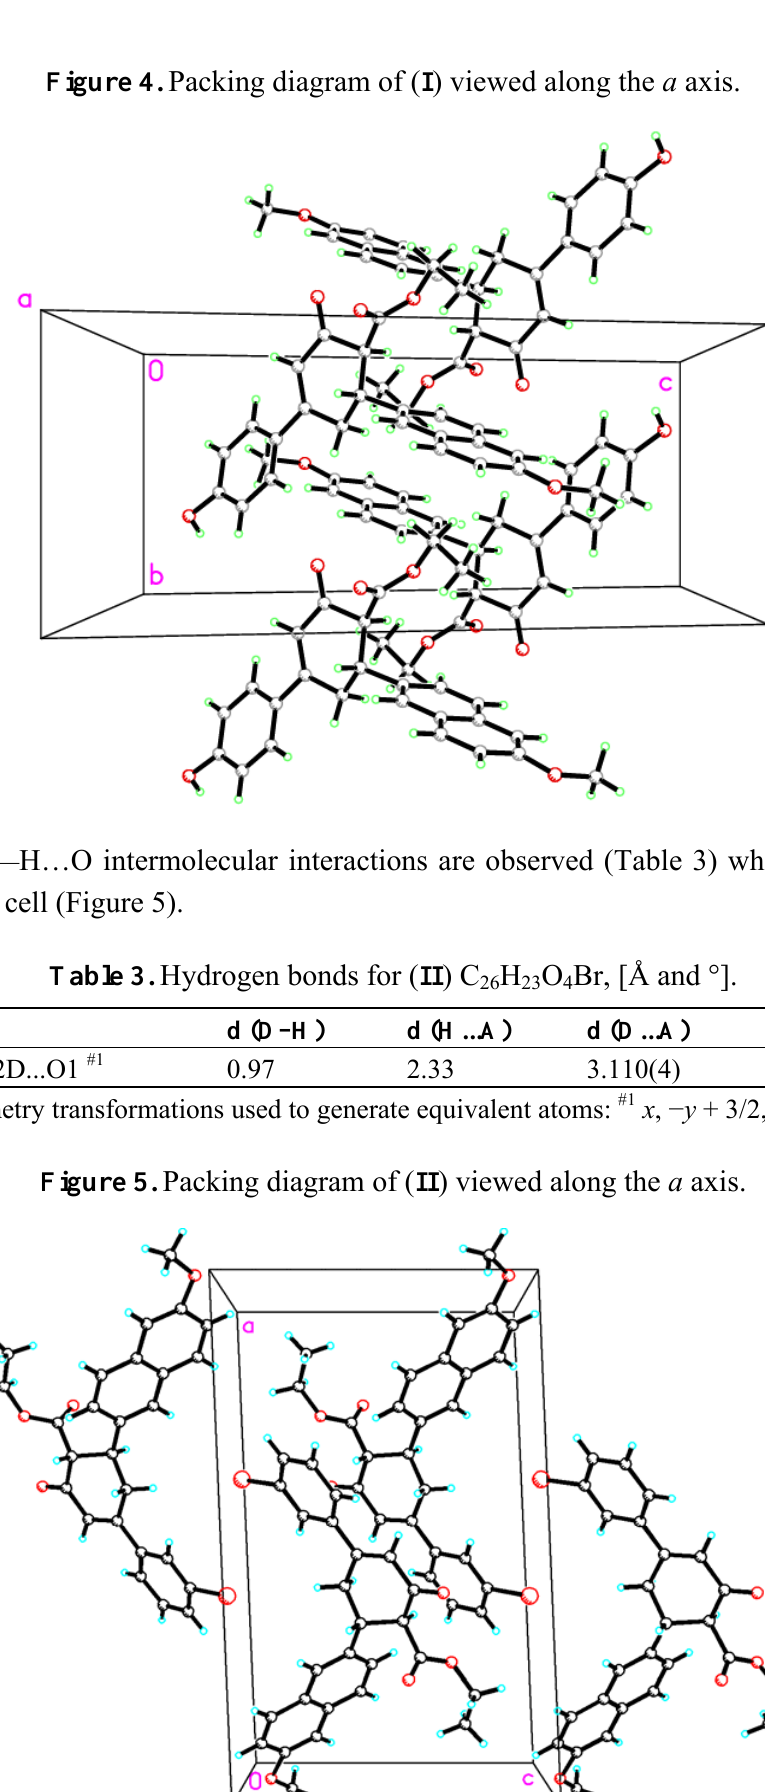
Figure 4. Packing diagram of ( I ) viewed along the a axis.